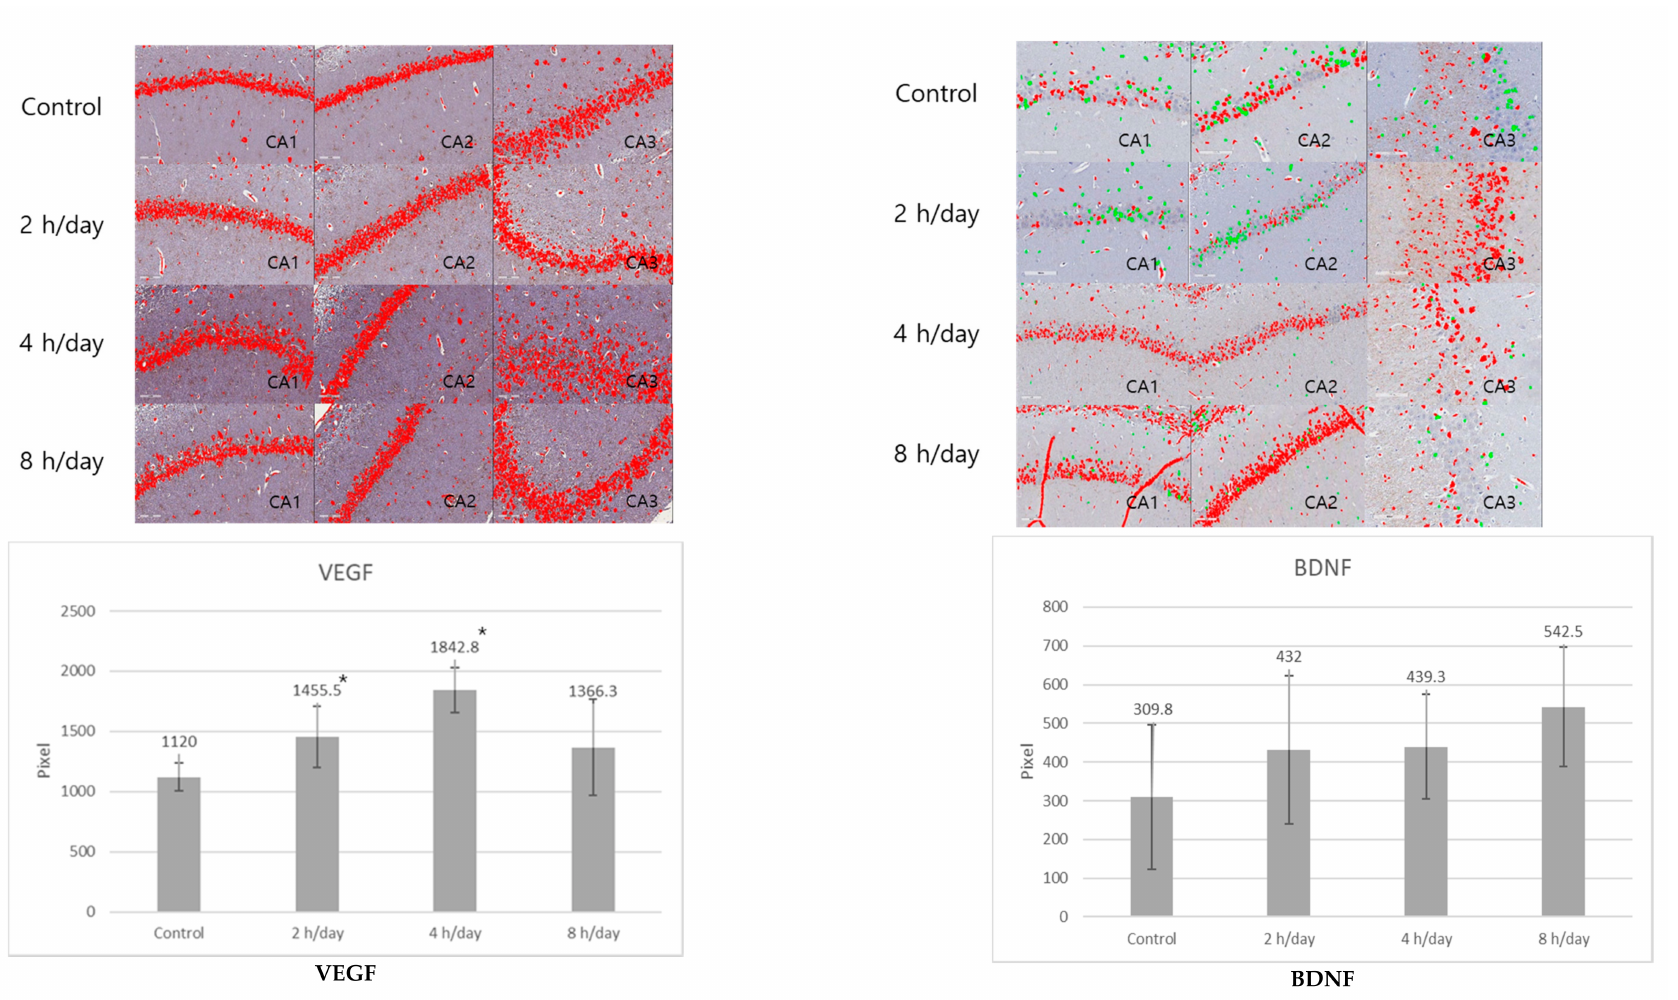
Figure 6. Immunohistochemistry for VEGF and BDNF expression and quantification of immunohistochemistry. Immunohistochemistry analyses of VEGF at hippocampal area revealed significantly greater immunoreactivity in the 2 and 4 h per day groups compared with the control group ( p = 0.015). * p < 0.05 compared with control